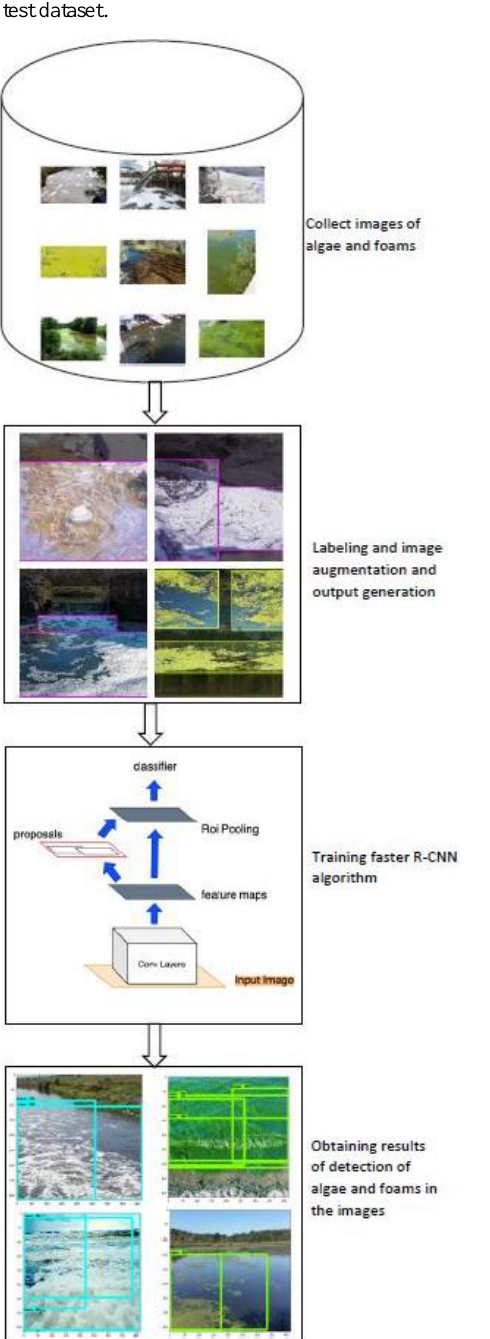
Figure 4 . Training steps of R-CNN model